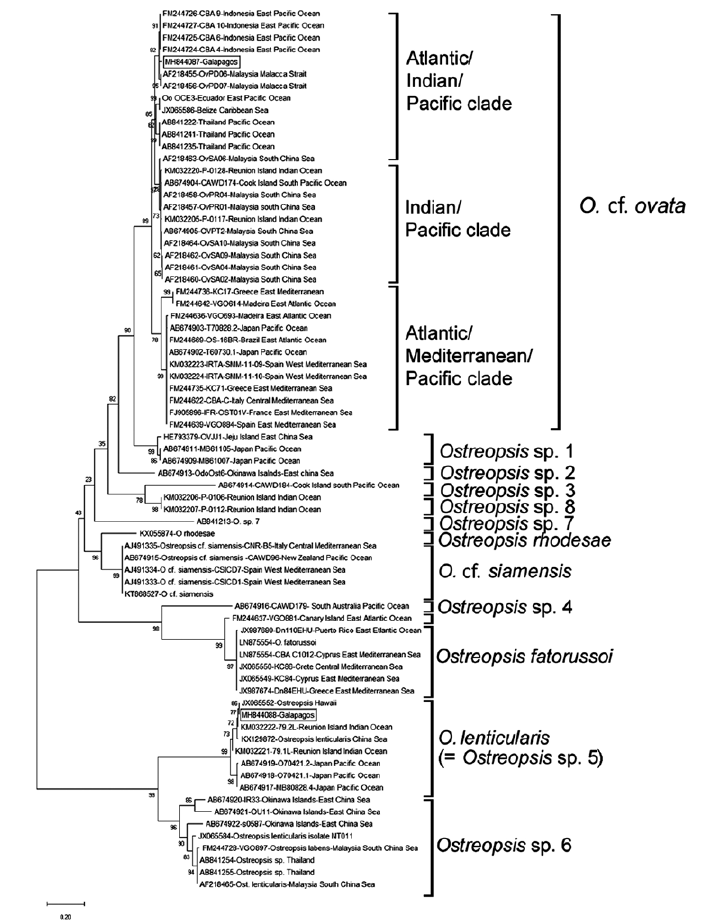
Fig. 3. – Evolutionary relationships of Ostreopsis spp. 5.8S rDNA and ITS regions. Bootstrap values (1000 replicates) are shown next to the branches. The tree is drawn to scale, with branch lengths in the same units as those of the evolutionary distances used to infer the phylogenetic tree. The tree with the highest log likelihood (-3268.95) is shown and is drawn to scale, with branch lengths measured in the number of substitutions per site. The percentage of trees in which the associated taxa clustered together is shown next to the